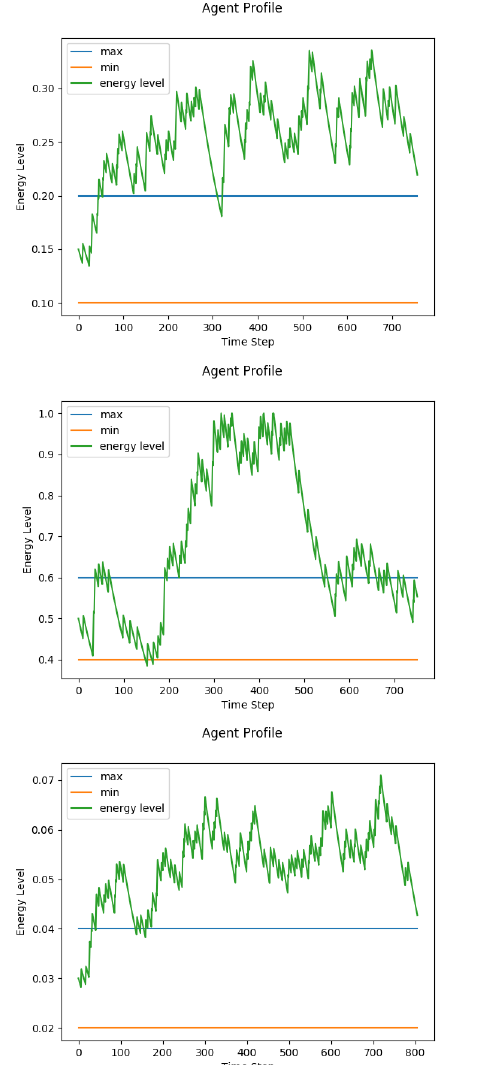
Figure 12. In these three graphs, the control of the A3CEG agent is shown over the current value of the internal variable (green line). It is observed that for different intervals of the variable, the agent’s behavior is coherent with external and internal goals. is the previous line color and C b is the recent line color, then the new line color C n is calculated as: C n = 99% C a +1% C b . The maze’s floor is colored white, and the maze’s walls are black. The lines are the tracks that show the agent’s